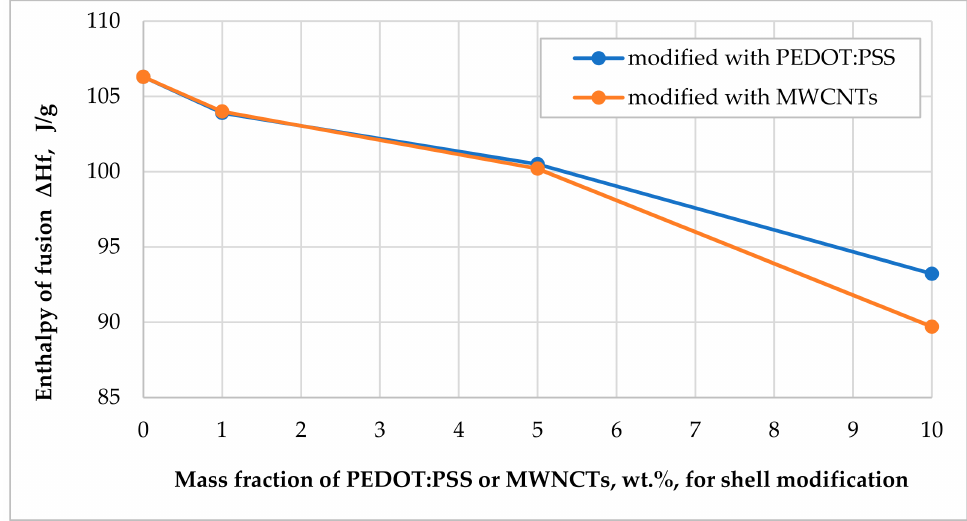
Figure 6. The influence of shell modifiers PEDOT: PSS and MWCNTs on fusion enthalpy of paraffin phase changing materials (PCMs)